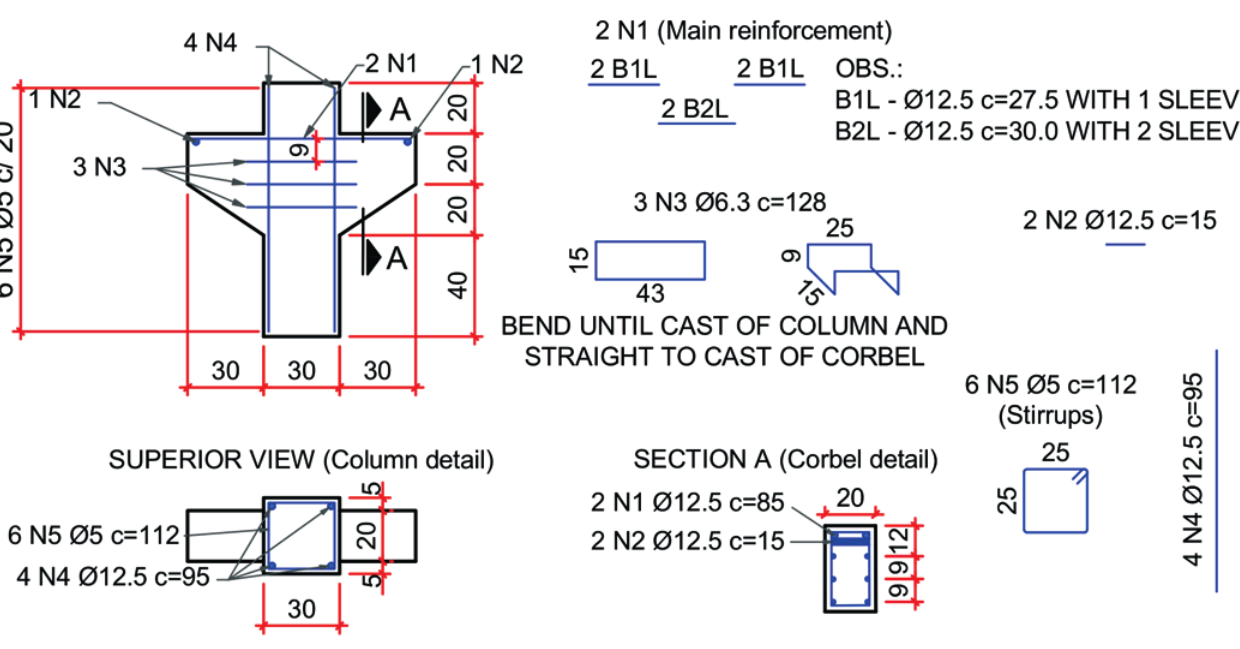
Reinforcement detail of model with corbel cast in a different stage from the column (P2) with main reinforcement spliced by sleeves and